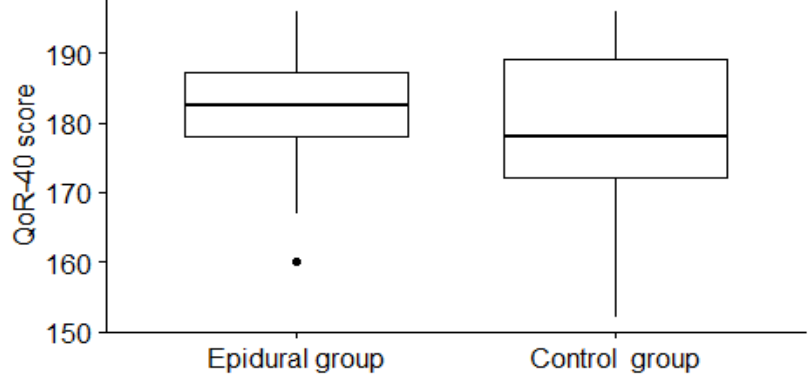
Figure 2. Global QoR: 40 scores in the epidural and control group. QoR-VAS was strongly correlated with QoR-40 ( r = 0.69, p ≤ 0.001) and with QoR-15 ( r = 0.65, p ≤